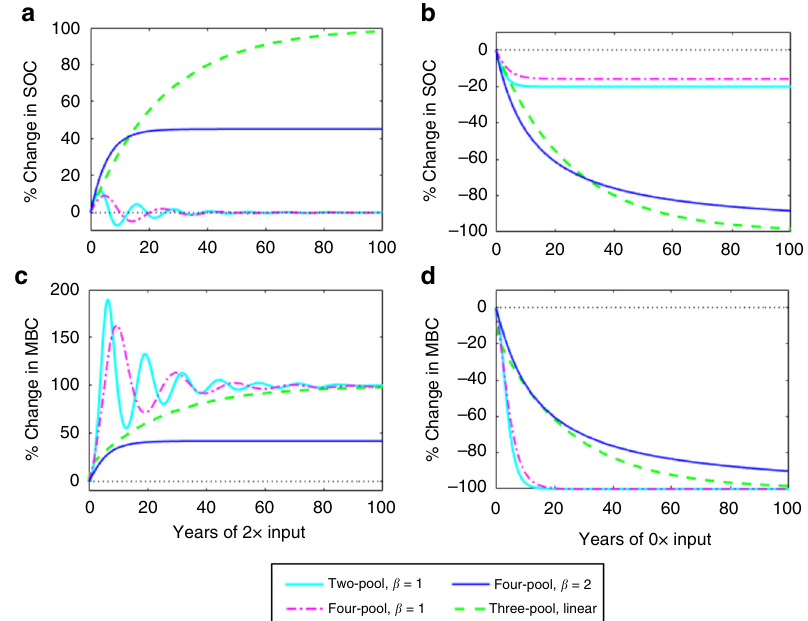
Fig. 5 Response of SOC and MBC to doubling and removal of C inputs in models. a , c Percent change of modeled SOC and MBC following a 2× step increase in inputs. b , d Percent change of modeled SOC and MBC following sustained 0× inputs. A value of β > 1 corresponds to a microbial model with density-dependent microbial turnover. The fi ve-pool microbial model overlaps with the four-pool microbial model for the parameter set in Supplementary Table 1